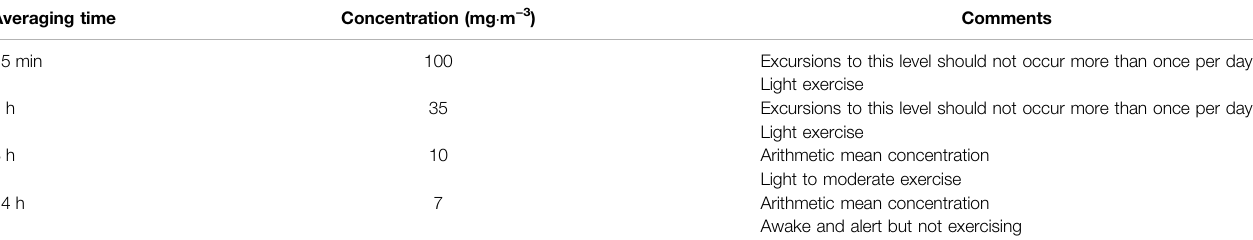
TABLE 2 | Indoor carbon monoxide guidelines World Health Organization (WHO) (World Health Organization, 2010). Averaging time